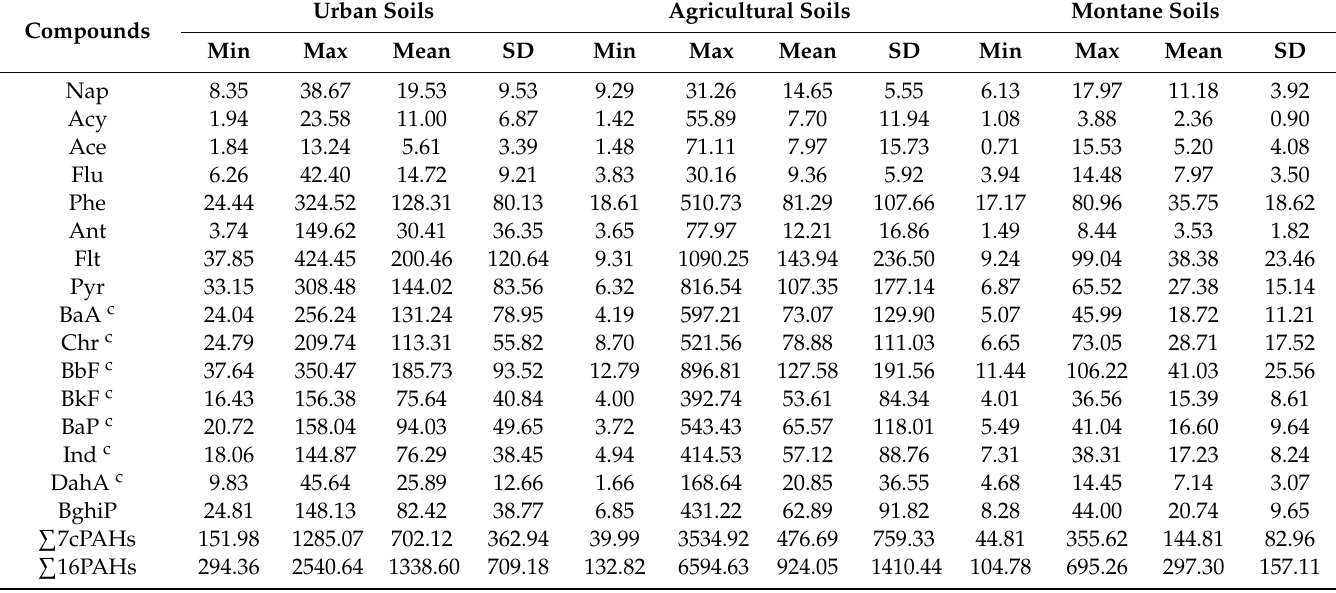
Table 1. Concentrations of polycyclic aromatic hydrocarbons (PAHs) in di ff erent types of surface soils from Taiyuan (ng g − 1 ). Urban Soils Agricultural Compounds